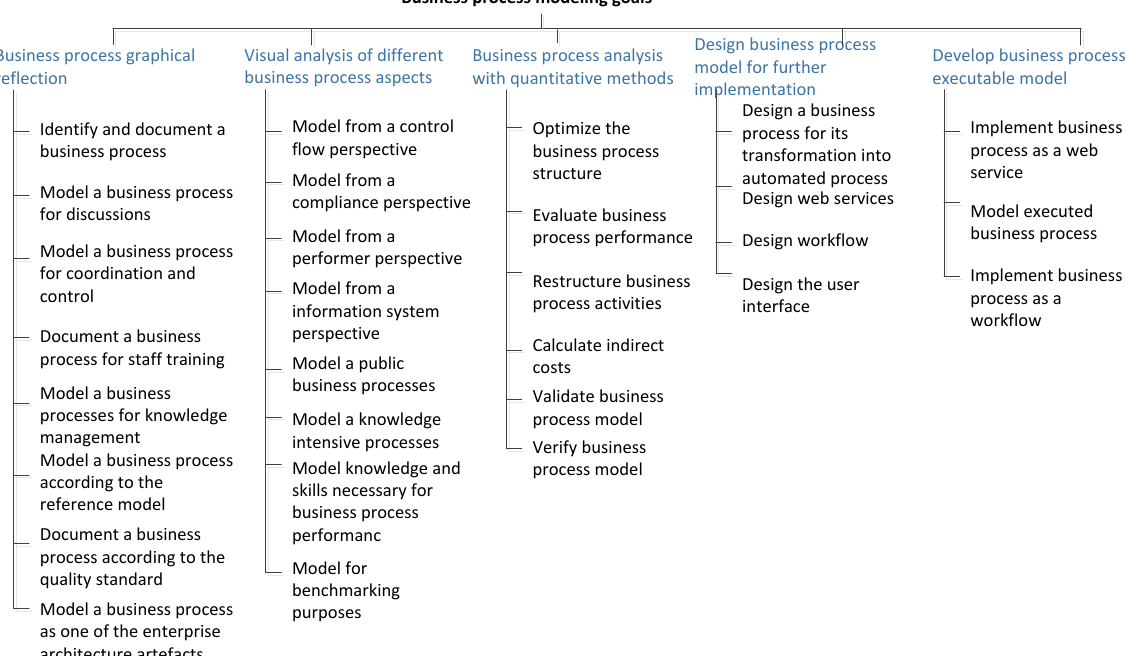
Figure 2. Groups of business process modeling